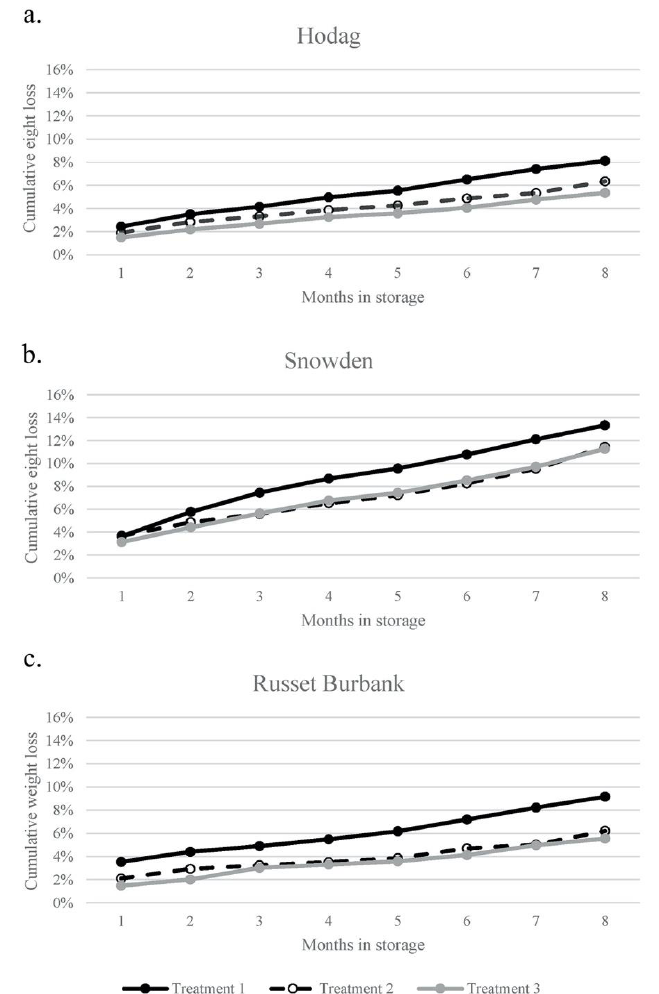
Figure 4. Cumulative monthly weight loss % of Hodag ( a ), Snowden ( b ), and Russet Burbank ( c ) under the three wound healing treatments in 2017. Least significant difference (LSD, α = 0.05) between each monthly weight loss measurement is 0.5% among varieties and treatments.